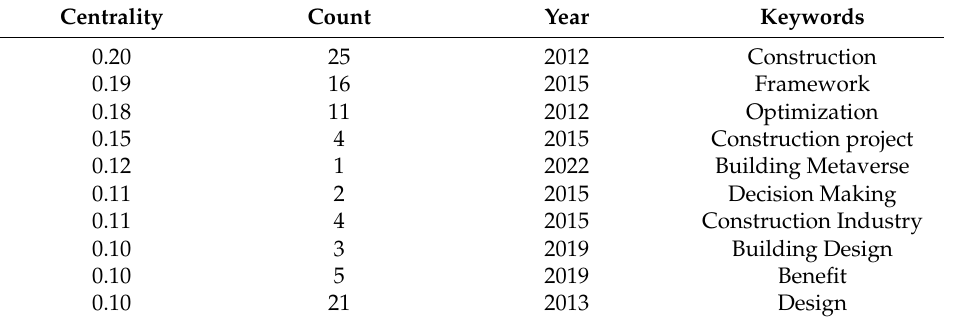
Table 2. Keywords with structural significance in the field of BIM–IoT-sustainable building via Citespace, whose centrality is greater than 0.1 (generated by the